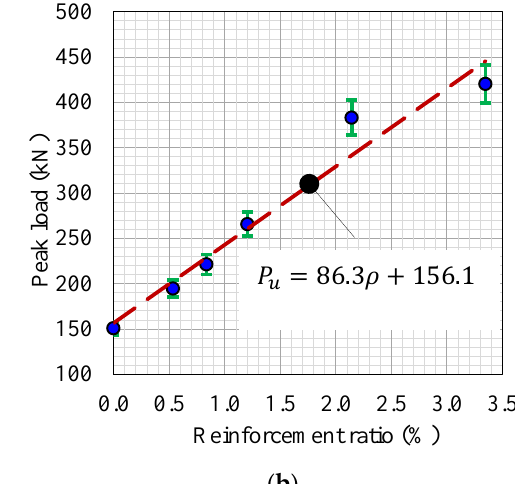
Figure 8. ( a ) Load – deflection of beams and ( b ) peak load-reinforcement ratio relation.